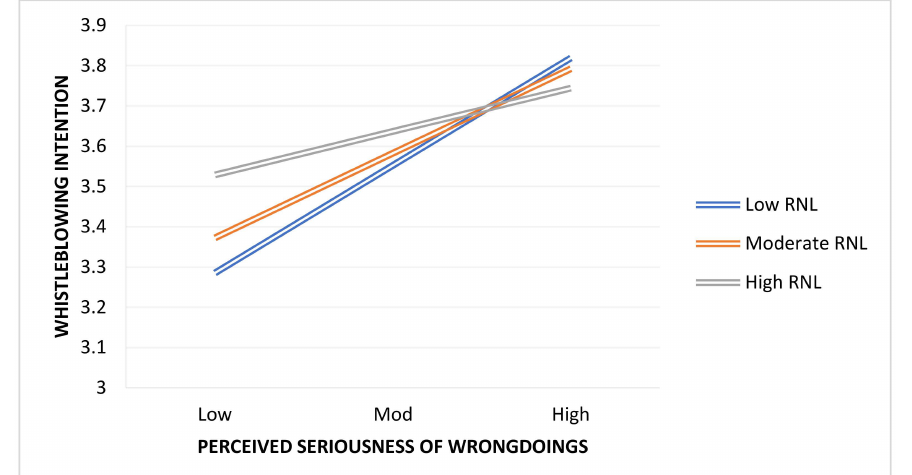
Figure 2. PSW*RNL = Whistleblowing